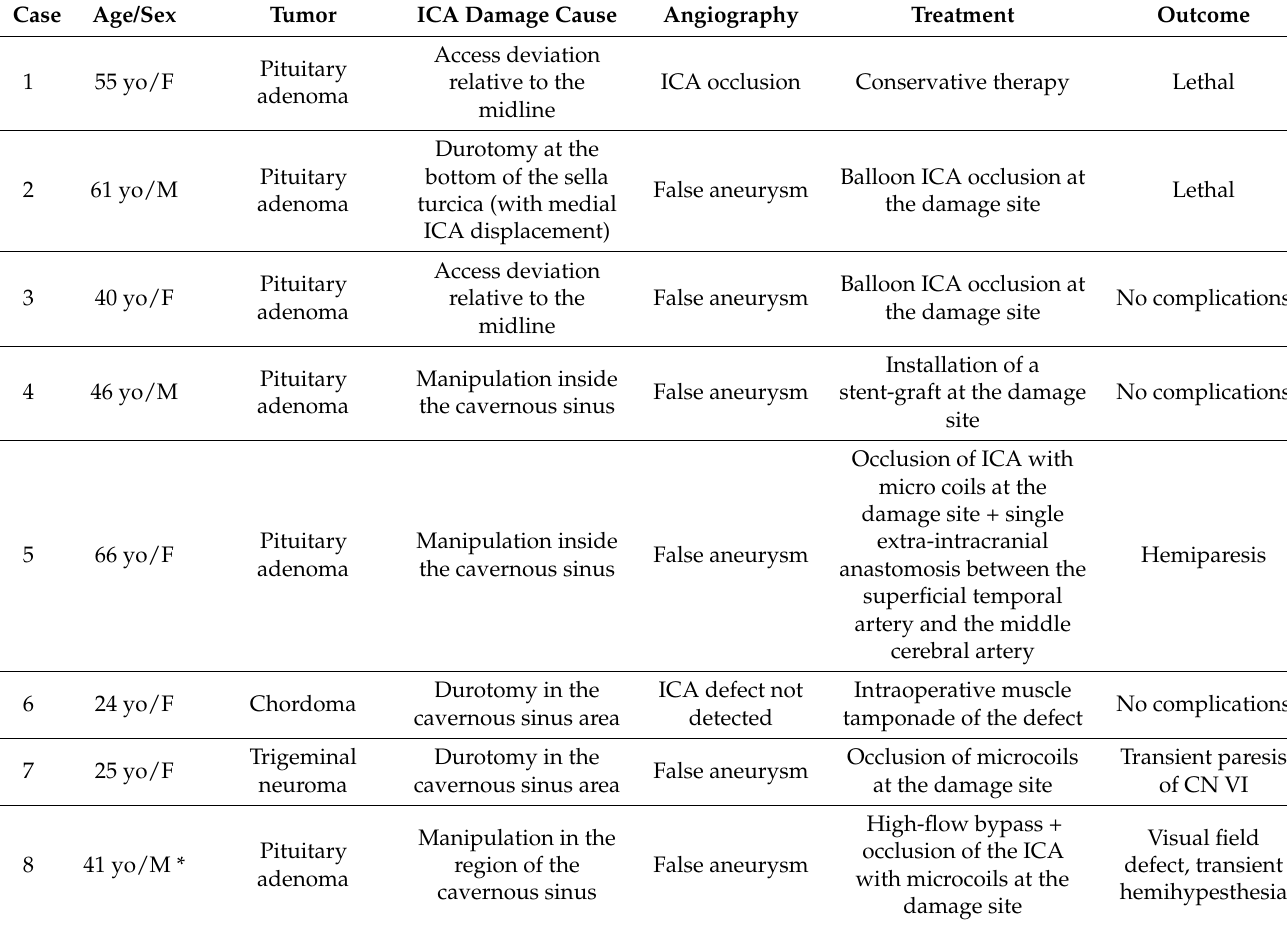
Table 1. Data of patients with ICA injury, treatment options, and